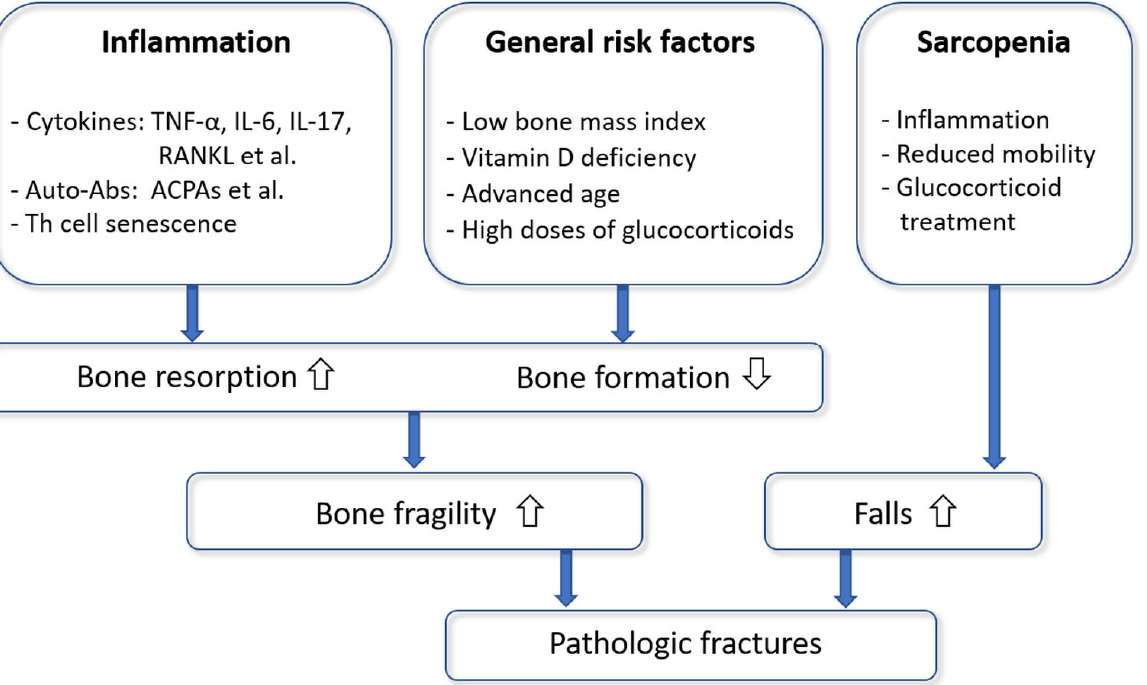
Figure 2. A model of the pathophysiology of osteoporotic fractures in rheumatoid arthritis.